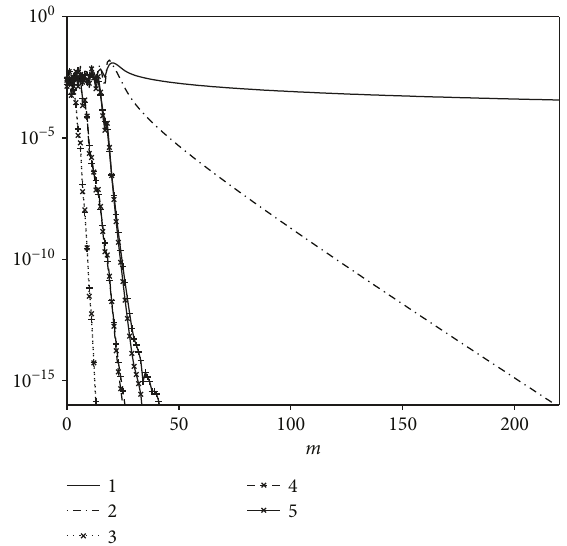
Figure 6: Absolute values of the terms in (26) for ρ = ρ K ∣ , (2) 1/2 π ∣ R I I ∣ , ∣ C I ∣ computed with equation π ∣ I m m m m m m m (40) for (3) Muscle1, (4) Leg2, and (5) Muscle4. The terms ∣ D m K m ∣ are indicated with